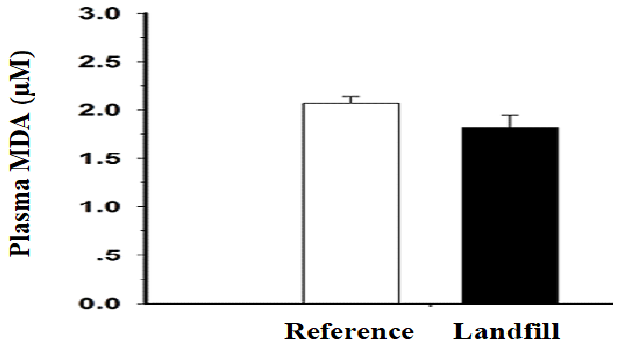
Figure 4. The levels of plasma malondialdehyde (MDA) in both groups of the hybrid catfish. Values are expressed as the mean ± standard deviation of 10 fish.